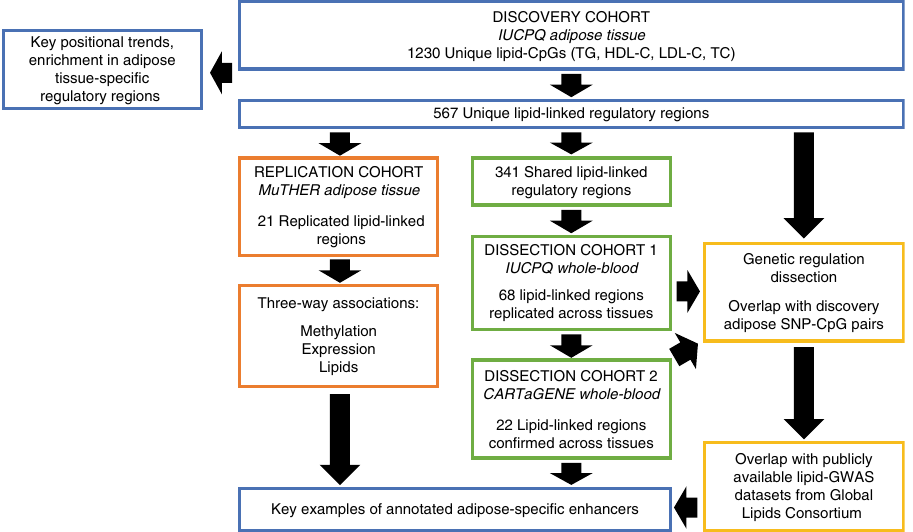
Fig. 1 Study fl ow chart. Overview of included study cohorts and follow-up analyses to characterize identi fi ed lipid-linked adipose tissue regulatory regions